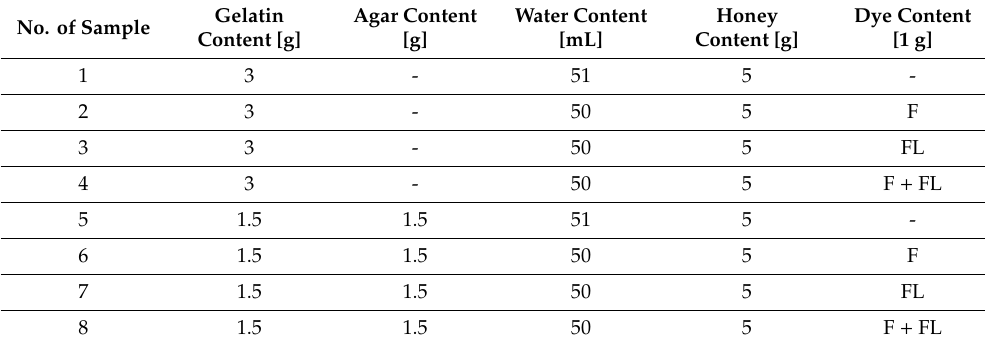
Table 1. Composition of produced